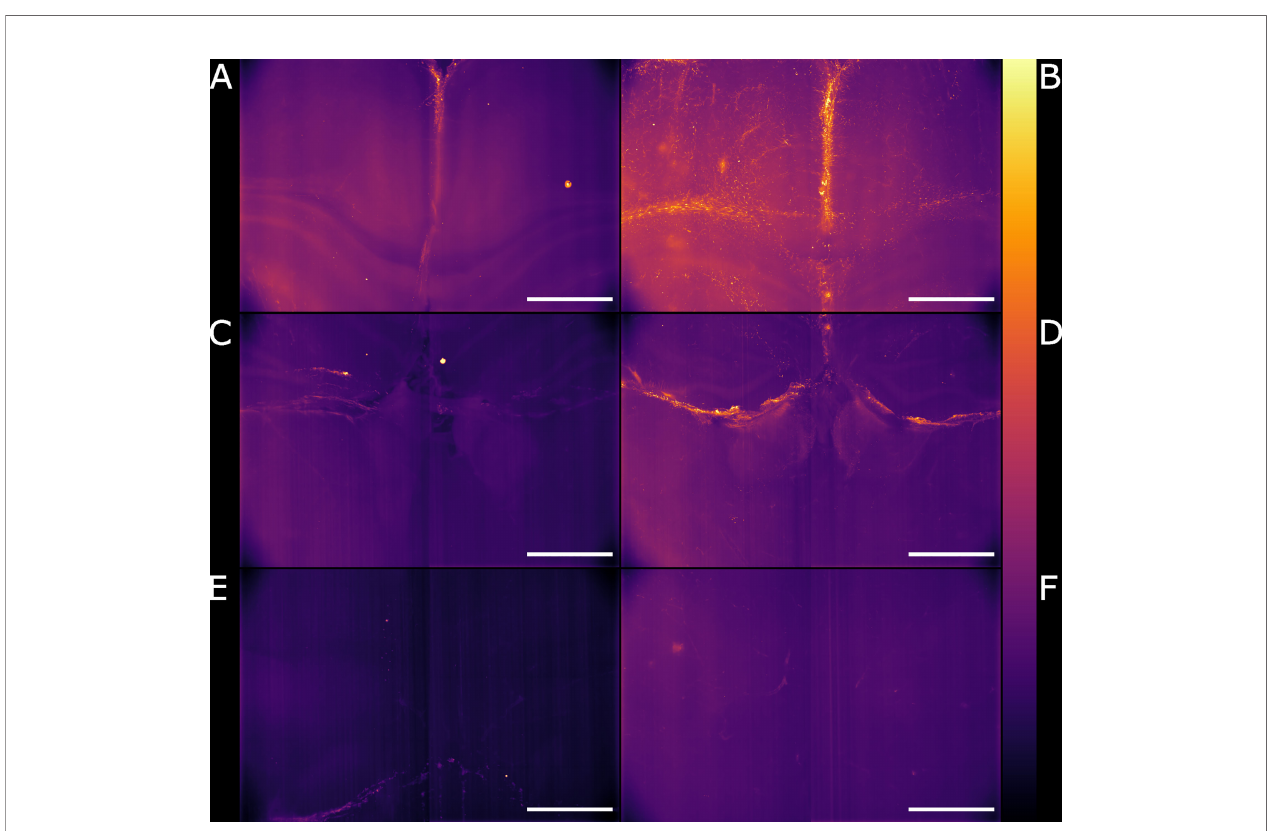
FIGURE 5 | Light-sheet Mesolens images of comparable volumes in the naïve and infected specimens. We imaged and processed images from three main brain regions: cingulate cortex in the (A) naïve and (B) infected specimens, corpus callosum and external capsule in the (C) naïve and (D) infected specimens, and hypothalamic area, including the fornix and the forebrain bundle in the (E) naïve and (F) infected specimens. The look-up table is mpl-inferno. Scale bar: 1000 µm. The images were converted to 8-bit values (0-255).